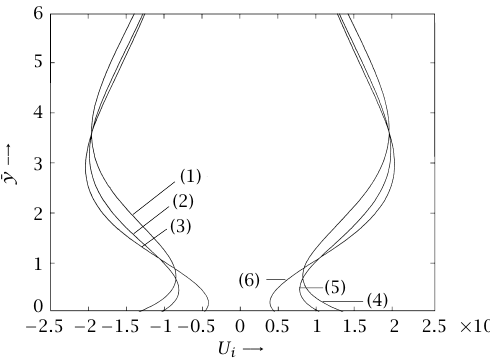
Figure 4.8 . Axial velocity component of the fluid U i in the boundary layer for R = 500, 4 = 0 . 05, t = 1. (1) X = − 0 . 5, λ = 0 . 01, (2) X = − 0 . 5, λ = 0 . 16, (3) X = − 0 . 5, λ = 0 . 31, (4) X = 0 . 5, λ = 0 . 01, (5) X = 0 . 5, λ = 0 . 16, (6) X = 0 . 5, λ = 0 . 31.